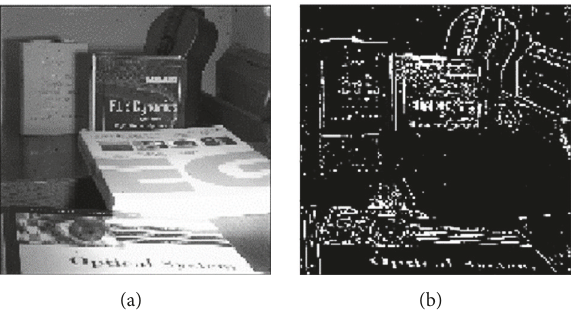
Figure 8: Source and normalized images of books (CVs). The original colour image “input” is available “for free” atthe website of T. Georgiev